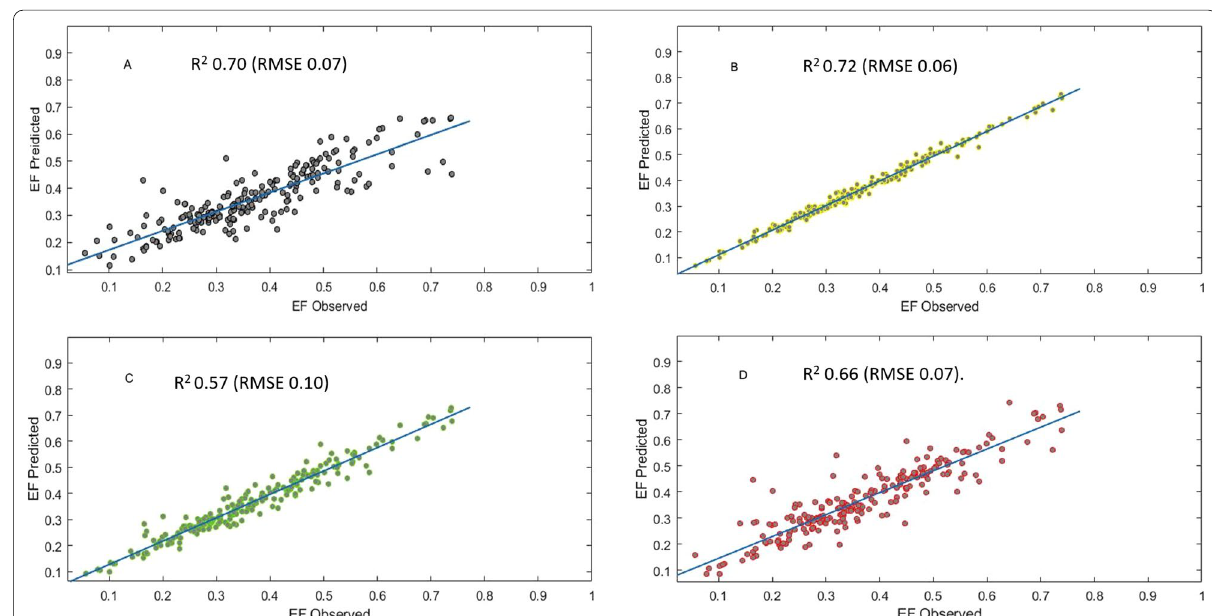
Fig. 5 Scatter plot between observed and predicted EF, during the testing phase of the four different approaches: the SVM polynomial model ( A ), GRP rational quadratic ( B ), GRP Matern 5/2 ( C ), and SVM cubic Gaussian ( D )